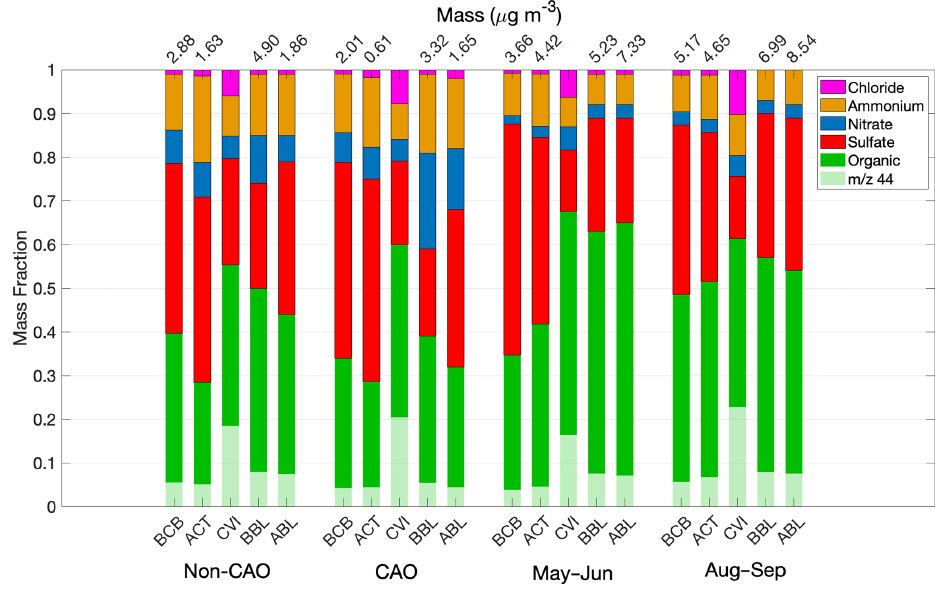
Figure 4. Seasonal comparison of AMS mass fractions, including the relative contribution of m/z 44 to total organic ( f 44 ). Numbers above each bar represent the mean total AMS mass concentration for that category; note that absolute masses are not reported downstream of a CVI owing to high uncertainties. Note that the non-CAO and CAO categories represent all flight data in January–March (deployments 1 and 3) that were separated using the criteria in Sect. 2.4.